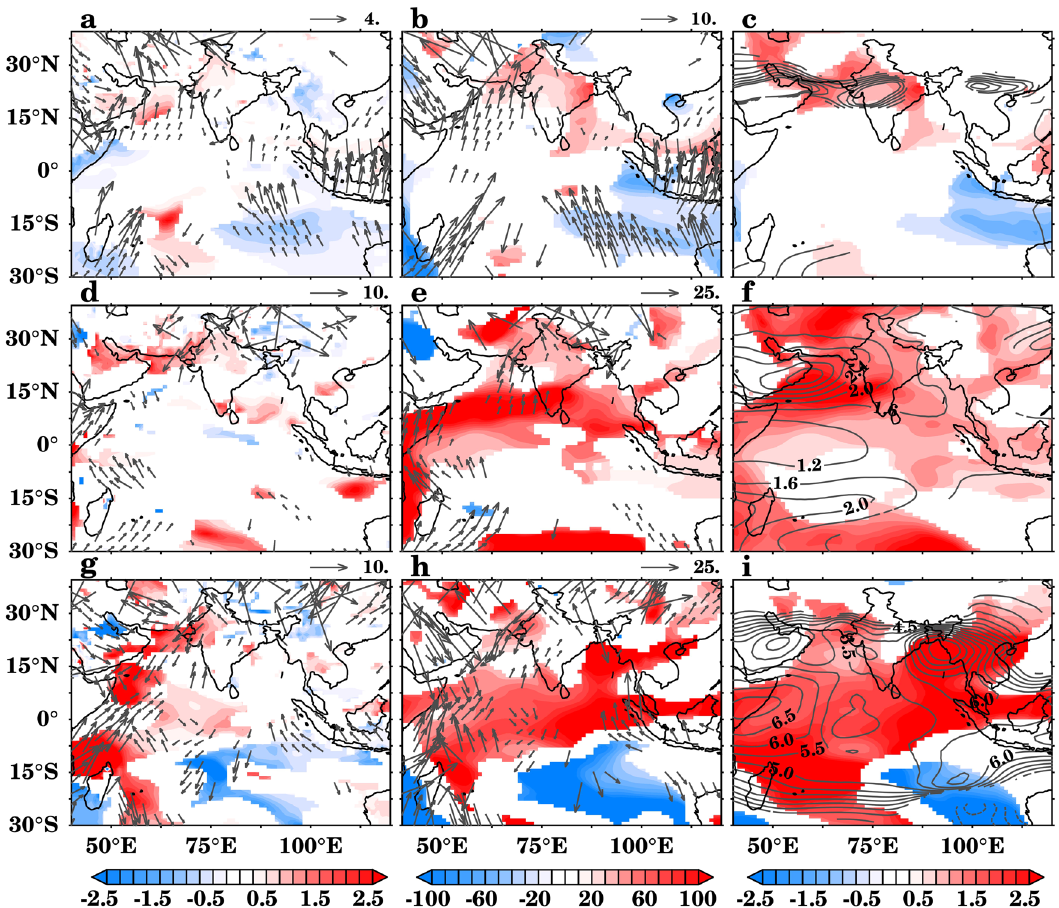
Fig. 5 Association of WG rainfall variability to circulation and moist thermodynamical processes. Regression of WGI (mm/day) with anomaly of a wind vector (m/s) at 850 hPa and vertical wind at 500 hPa (shaded; mm/s). b Vertically integrated (1000 – 300 hPa) moisture transport (vector; kg/m.s) and vertically integrated moisture (shaded; kg/m 2 ). c Tropospheric Temperature averaged over the 600 – 200 hPa (contour, °C) and moist static energy averaged over the 1000 – 200 hPa (shaded; kJ/kg) for period 1. d , e , f same as a , b , and c but for Period 2. g , h , i same as a , b , and c but for Period 3. Only values quali fi es 90% con fi dence level are